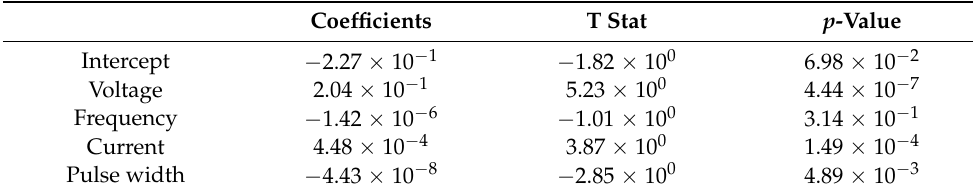
Table 2. Multiple regression analysis between mortality and electrical